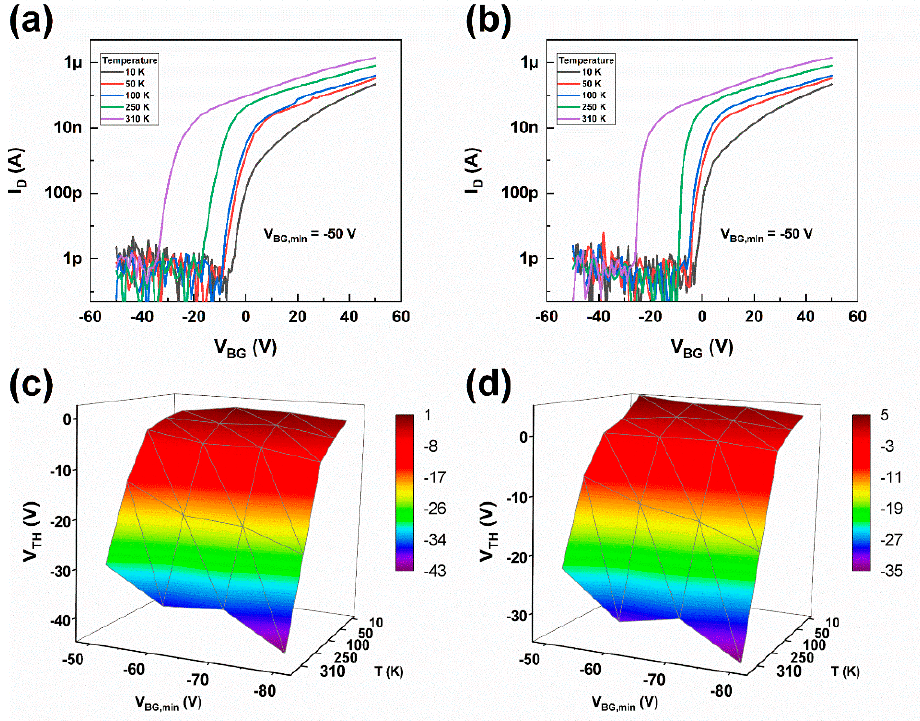
Figure 3. Transfer curves at a series of temperatures (10–310 K) for forward sweep ( a ) and backward sweep ( b ), respectively. Relationship between V TH , V BG, min , and temperature for forward sweep ( c ) and backward sweep ( d ), respectively.